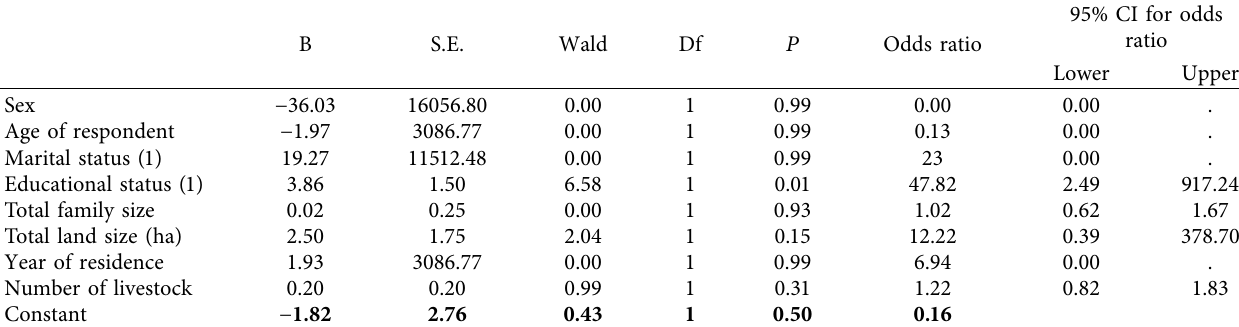
Table 2: Logistic regression predicting the likelihood of reporting willingness to sustain Acacia seyal in cropland.